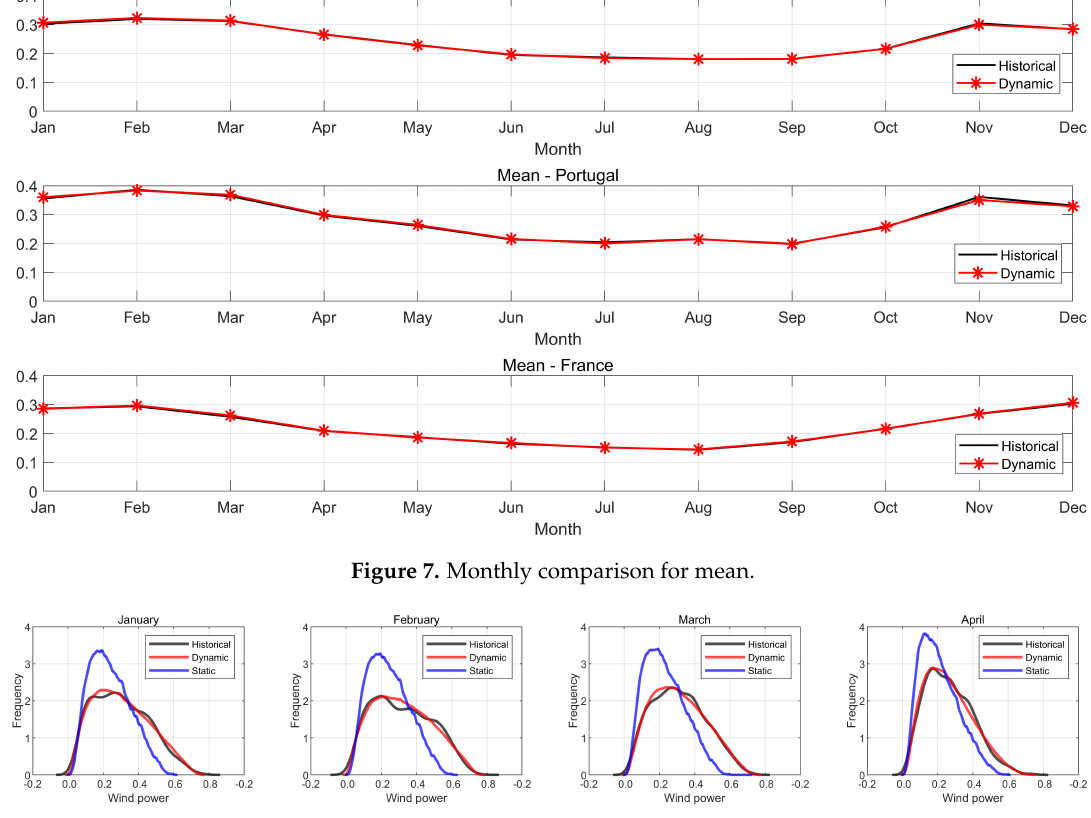
Figure 7. Monthly comparison for mean.